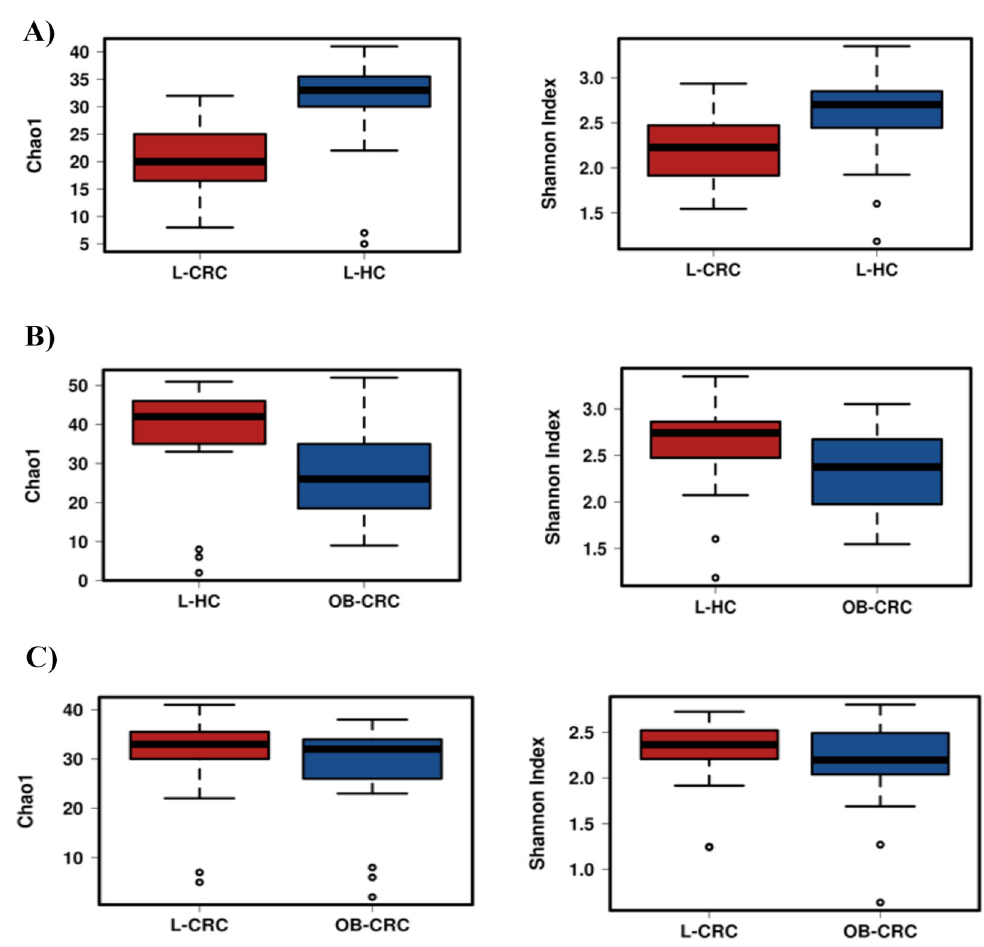
Figure 1. Richness (Chao1 index) and diversity (Shannon index) indices between microbial communities from feces of CRC patients with obesity (OB-CRC), non-obese CRC patients (L-CRC), and non-obese healthy controls (L-HC) at the genus level. ( A ) L-CRC vs. L-HC, ( B ) L-HC vs. OB-CRC, and ( C ) L-CRC vs. OB-CRC.